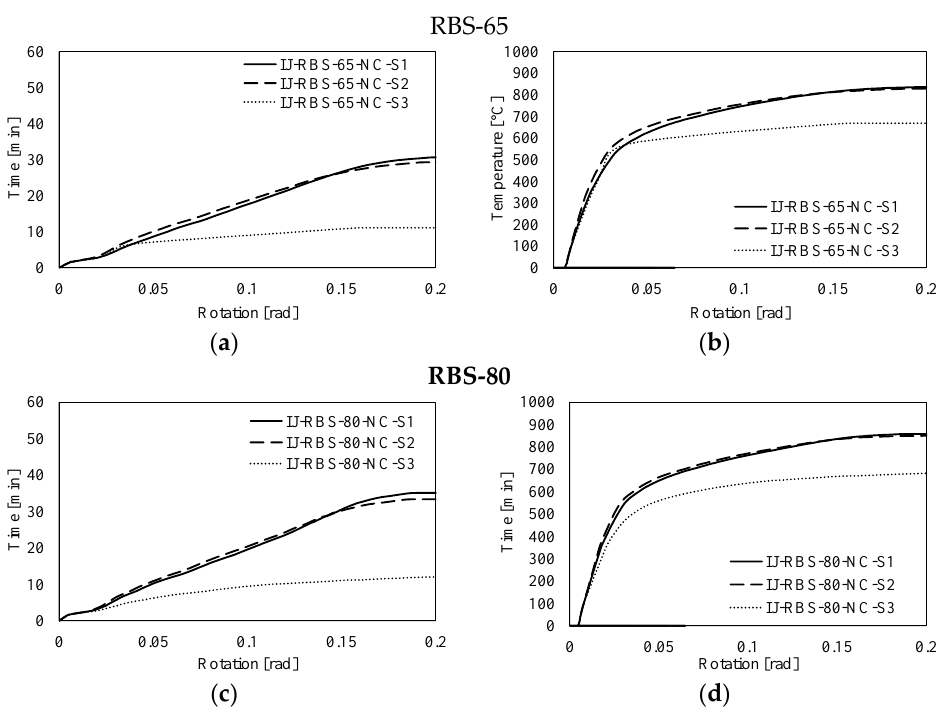
Figure 11. Time–rotation ( a , c ) and temperature–rotation ( b , d ) of the RBS-65/85 internal joints subjected to the S1–S3 scenarios.